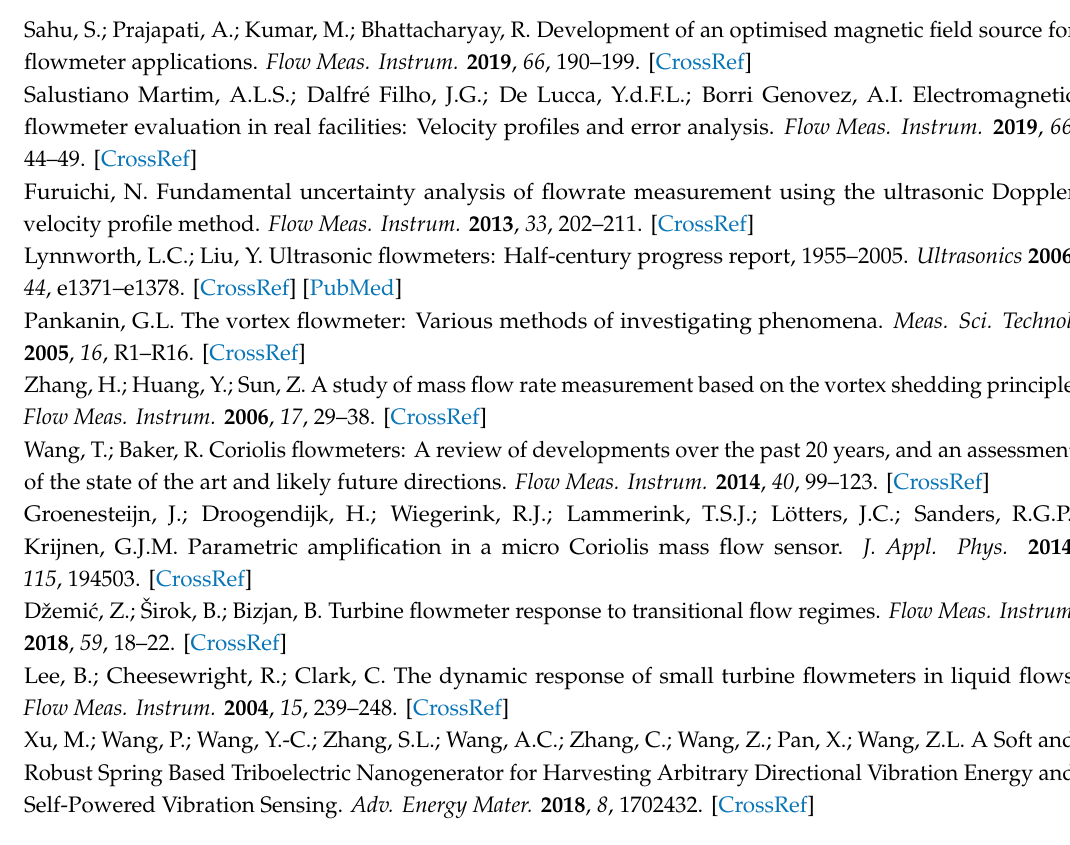
Figure S1: Fluttering images of PTFE membrane of thickness h = 0.05 mm, width W = 14 mm, and Um = 7.86 m / s with various length from 40 to 90 mm by a high speed camera. Figure S2: (a) Pressure loss of TENG flowmeter of with various widths, (b) lengths. Figure S3: The comparison of noise signal measured at the membrane is stable, and the sensor signal when the membrane is fluttering at the wind speed of 7 m / s. Video S1: Demonstration of the TENG flowmeter for measuring flow